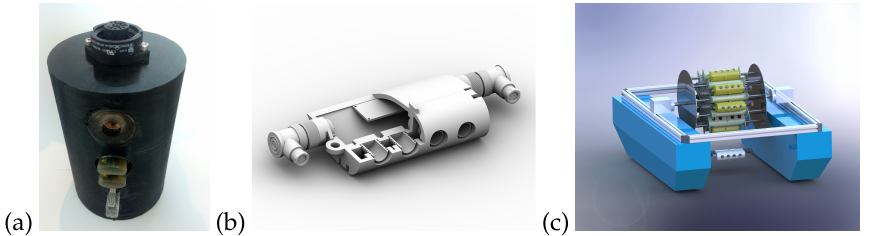
Figure 4. ( a ) photo of the first prototype, ( b ) 3D-model of the second prototype sensor node [33] and ( c ) cad-model of the winch